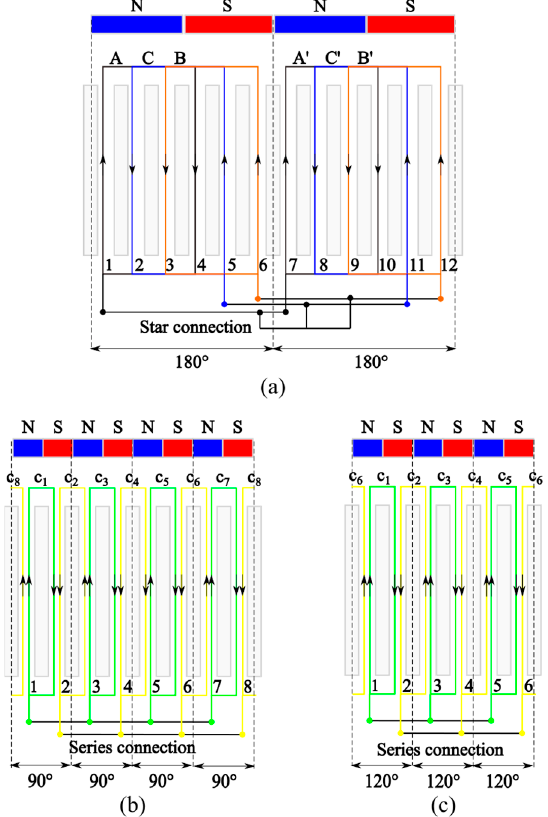
Figure 3. M 1 ( a ); M 2 ( b ); M 3 ( c ) topologies representation with a cross-section of the rotor, magnets and coils.